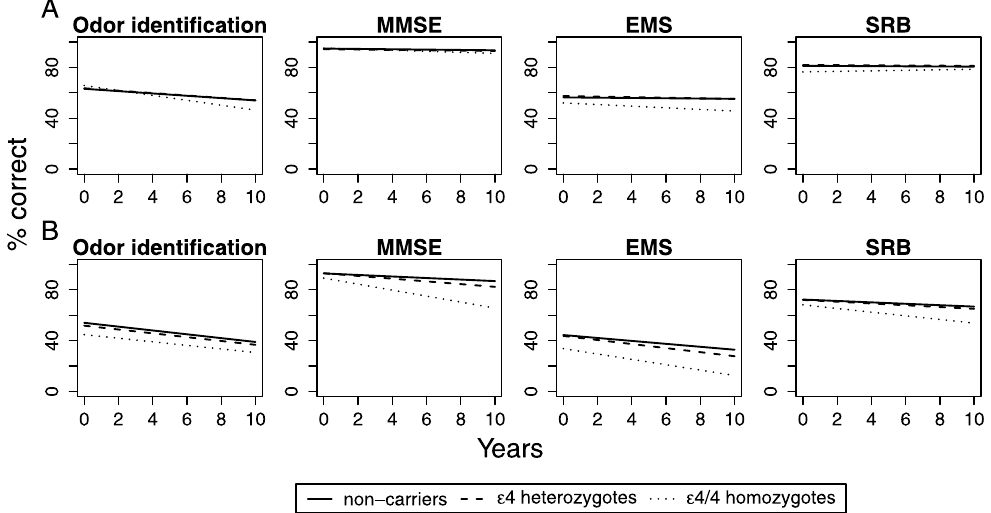
Figure 1. Estimated 10-year change in odor identification and non-olfactory cognitive tasks stratified by APOE group. Intercept and slopes are derived from mixed models. Panel A: Middle-aged participants. Panel B: Old participants.